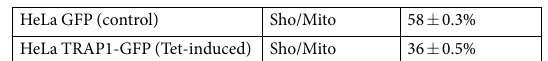
Table 1. Amount of Sho colocalizing with mitochondria. Quantification of immunofluorescence assays of Supplementary Fig. S6. Colocalization between Sho and Mitochondria was determined in at least 82 cells from three different experiments under control (HeLa GFP) or TRAP1 induced cells (HeLa TRAP1-GFP). The number of colocalizing red (Sho) and green pixels was normalized for the total number of pixels from an extracted region of interest in the confocal image. The results are expressed in percentage ± S.D; P <